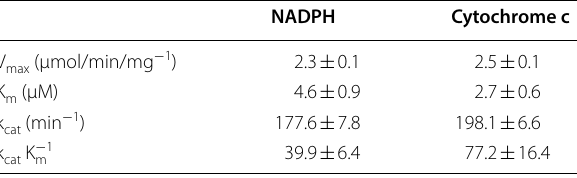
Table 3 Steady-state kinetic constant of cytochrome c and NADPH